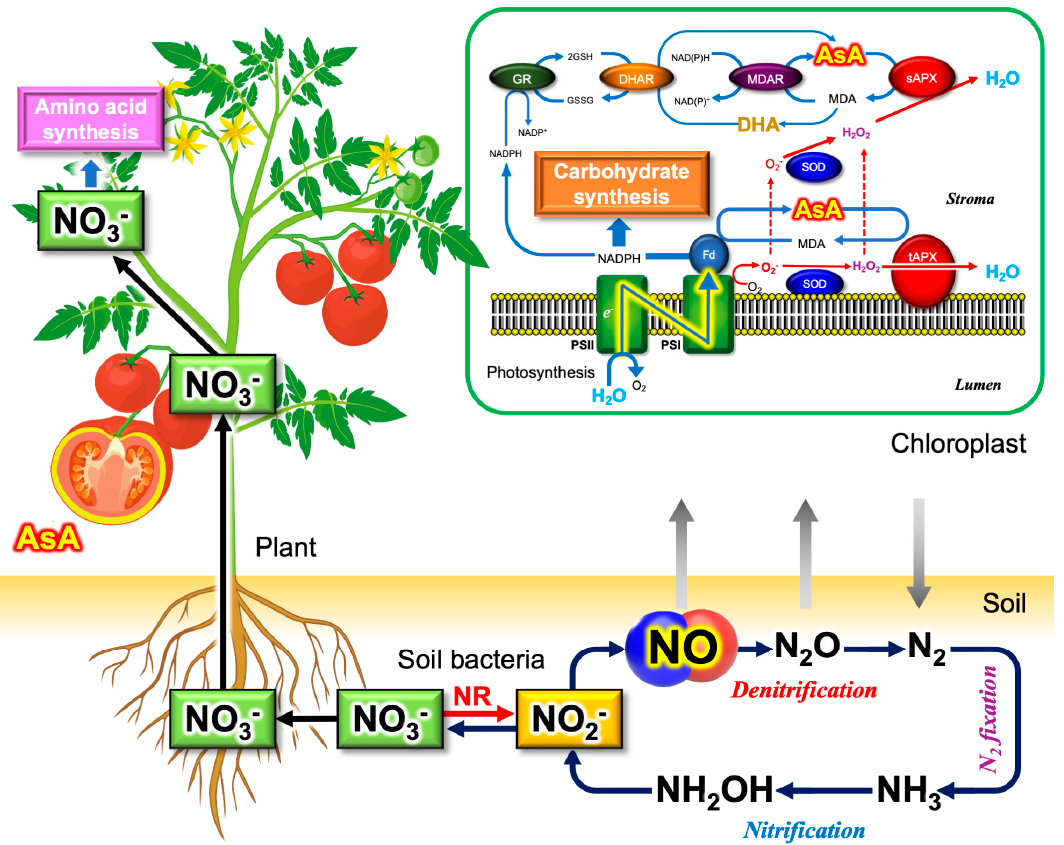
Figure 3. Nitrate and vitamin C in vegetables and fruits. On Earth, plants and soil bacteria sustain the global nitrogen (N) cycle, which is essential for recycling the N contained in biomolecules, including proteins and nucleic acids. NO is involved in this global cycle through the denitrification activities of soil bacteria. Both denitrifying and nitrifying bacteria produce inorganic nitrite (NO 2 − ) as an intermediate metabolite [124–126]. NO 3 − is absorbed by the roots, followed by being delivered to the green leaves where photosynthetic CO 2 assimilation takes place. NO 3 − is reduced to NO 2 − in the cytosol and further reduced to glutamate using light energy. In addition to nitrogen assimilation, chloroplasts are involved in the synthesis of cysteine using light energy. During the three major assimilation metabolisms, ROS, RNS, and RSS are produced as the byproducts [127], which is a strong reason why green leaves contain potent antioxidant systems [128]. In plant cells, NO is produced by reductive mechanisms [91,129,130]. Ascorbate accumulates in fruits and leaves. In leaves, ascorbate is present at high concentrations in the chloroplast stroma, such as 25 mM [131]. Ascorbate in the chloroplast is essential to detoxify ROS produced during the photosynthetic electron transport. Ascorbate is used to remove H 2 O 2 by ascorbate peroxidase (APX), and the oxidized ascorbate monodehydroascorbate (MDA) and dehydroascorbate (DHA) are quickly reduced to regenerate ascorbate using light energy. The inset shows a schematic diagram for the water-water cycle [132]. Ascorbate also accumulates in fruits at high concentrations. In tomato fruits, the ascorbate content in red fruits is higher than that in green fruits [133]. The localization of ascorbate in a tomato fruit is shown in yellow. AsA, L -ascorbic acid (vitamin C); MDA, monodehydroascorbate; DHA, dehydroascorbate; tAPX, thylakoidal ascorbate peroxidase; sAPX, stromal ascorbate peroxidase; MDAR, monohydroascorbate reductase; DHAR, dehydroascorbate reductase; GR, glutathione reductase; SOD, superoxide dismutase; Fd, ferredoxin, PSI, photosystem I complex; PSII, photosystem II complex; NR, nitrate reductase.